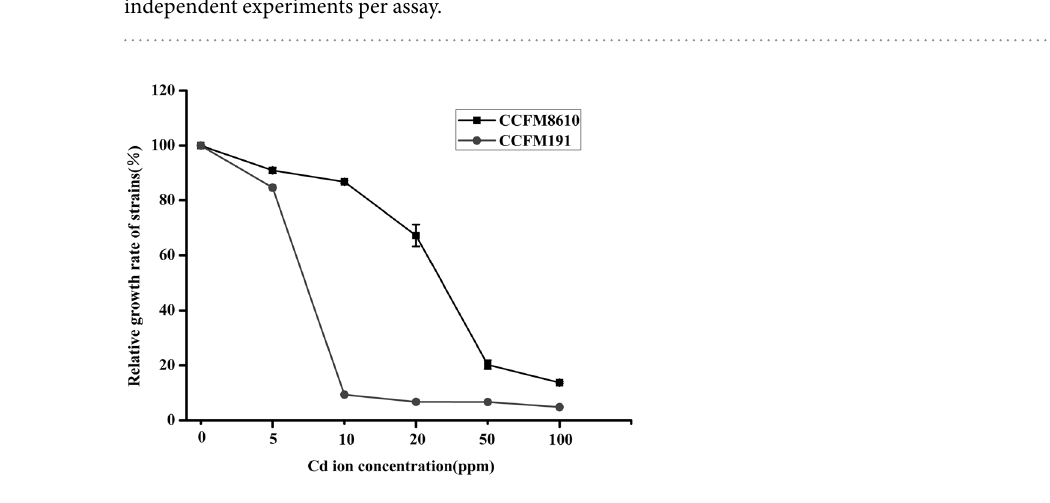
Figure 1. Relative growth rate of L . plantarum CCFM8610 and CCFM191 grown in MRS broth of different Cd concentrations. Relative growth rate was expressed as percentage of OD 600 value of control culture (without Cd exposure) which was assigned a value of 100%. Data are expressed as mean ± SEM of three independent experiments per